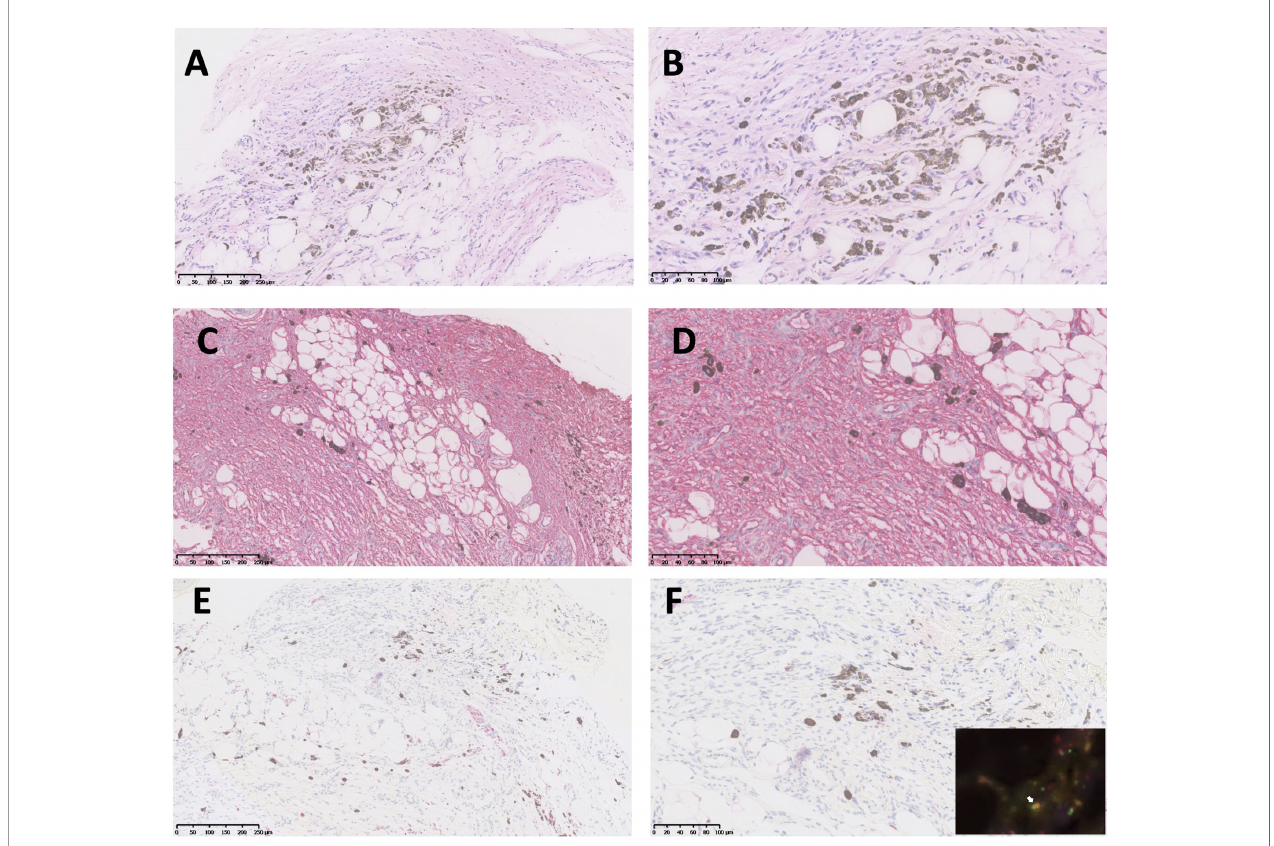
FIGURE 2 | Histopathologic and immunohistochemical analyses of atrophic pigmented DFSP. (A, B) Proliferation of spindle cells in dermis and scattered pigmented cells (hematoxylin and eosin, 100× and 200× magni fi cation). (C, D) Diffuse and strong expression of CD34 (100× and 200× magni fi cation). (E, F) Pigmented cells positive for S100 (100× and 200× magni fi cation). PDGFB and COL1A1 gene fusion was detected by FISH ( F , insert, white arrow).